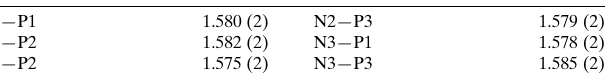
Selected bond lengths (A˚